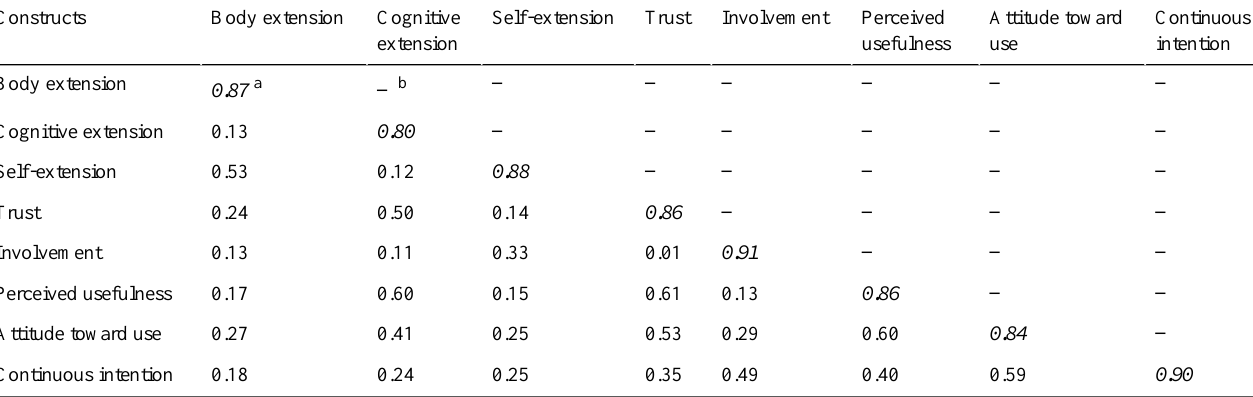
Table 5. Discriminant validity testing: average variance extracted (italics) versus crossconstruct squared correlations between the